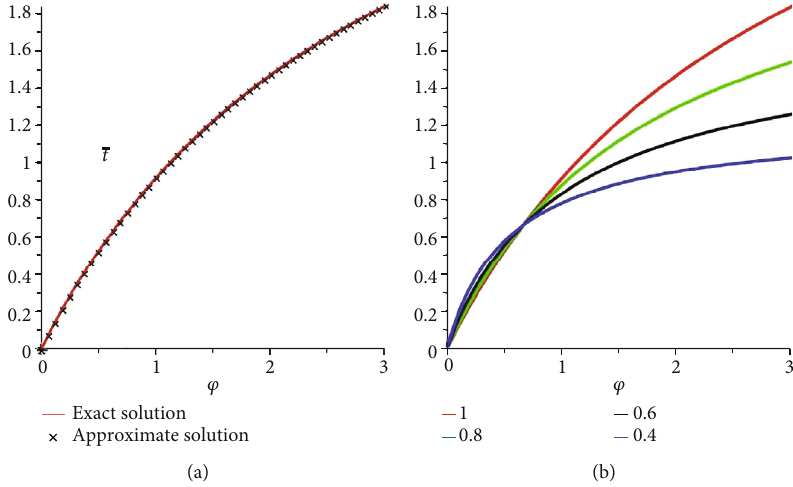
Figure 1: (a) Graph of approximate and exact result and (b) the second graph of various fractional order of β of Case 1.